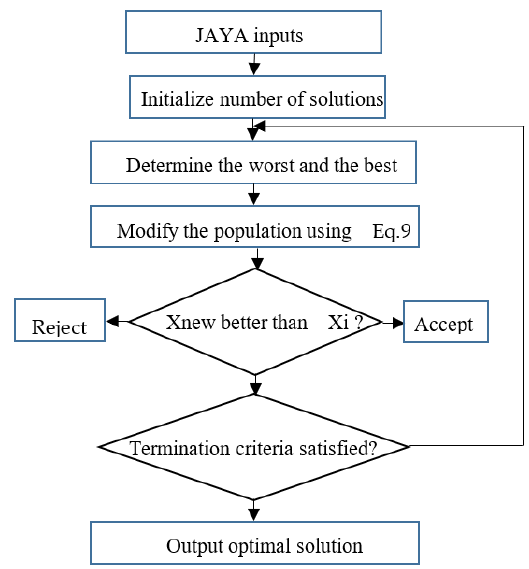
Figure 4. Flowchart of the original JAYA algorithm.